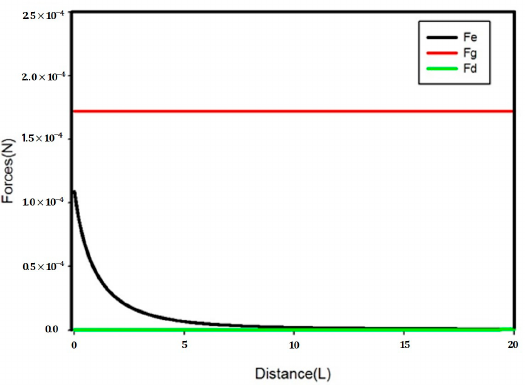
Figure 6. Magnitude of forces acting on a conductive particle as horizontal distance. (Radius of copper wire ( r (cid:2926) ): 0.00025 m, length of copper wire ( l (cid:2926) ): 0.01 m, and applied voltage (U): 20 kV).